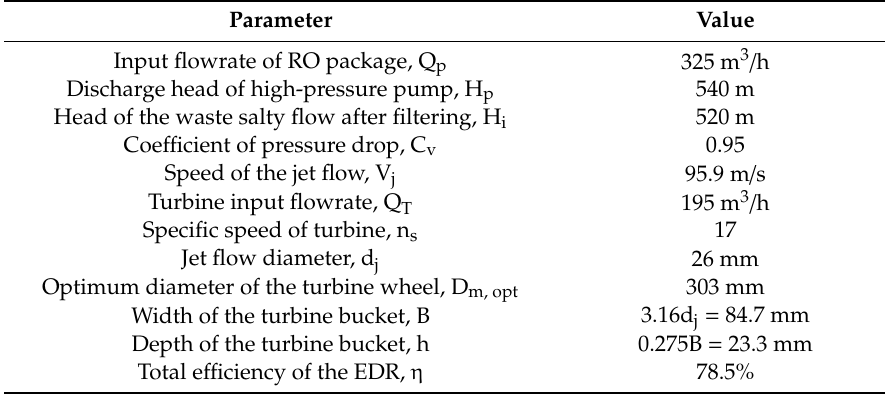
Table 3. Regulating valve calculation for the full opening condition [ Error! Reference source not found. ].